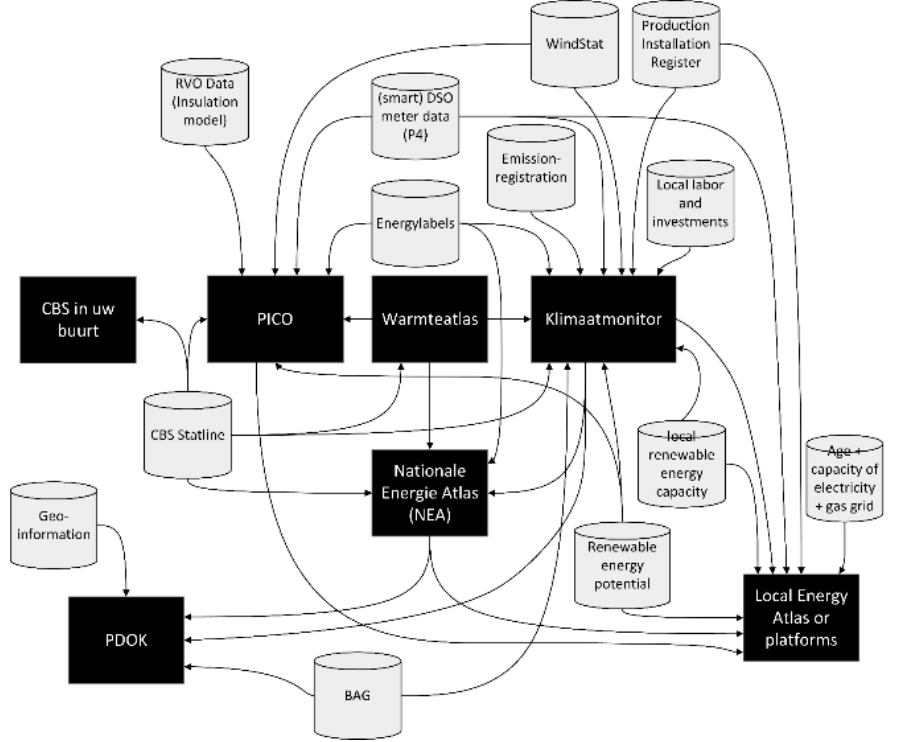
Figure A2. Visualization of how the platform uses the data from Figure A1.